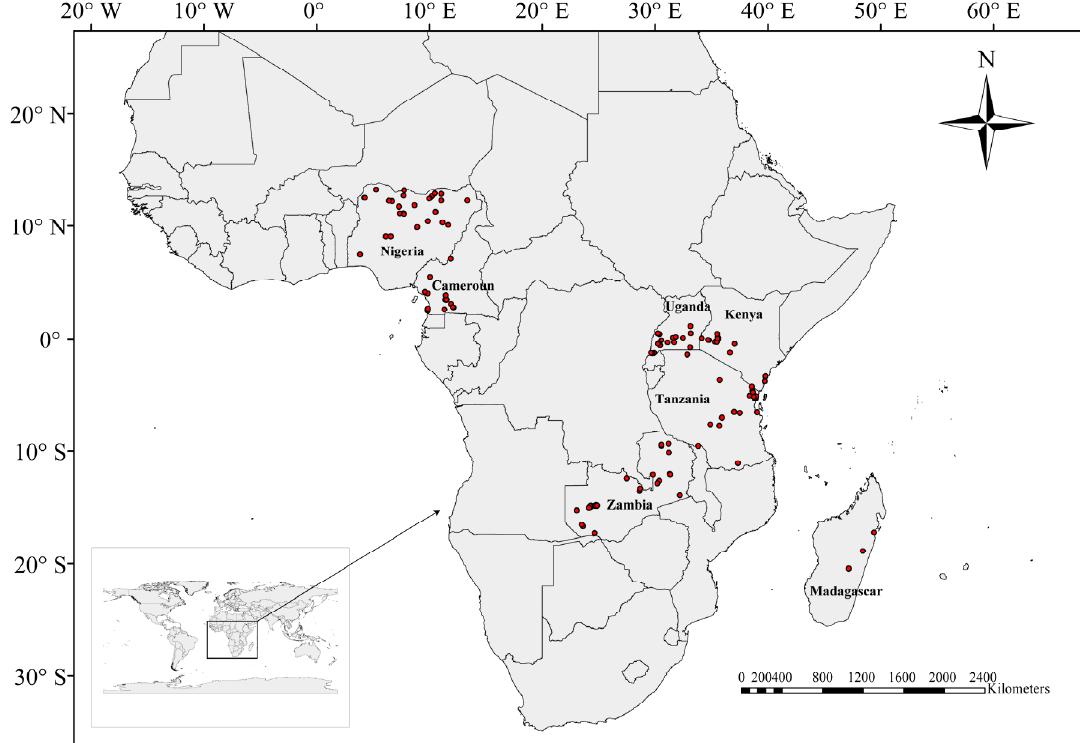
Figure 4. Sampling sites in seven African countries.